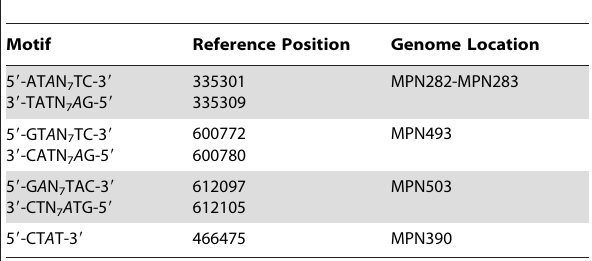
Table 3. Instances of genomic positions in M. pneumoniae consistently detected as lacking methylation across all three samples sequenced.